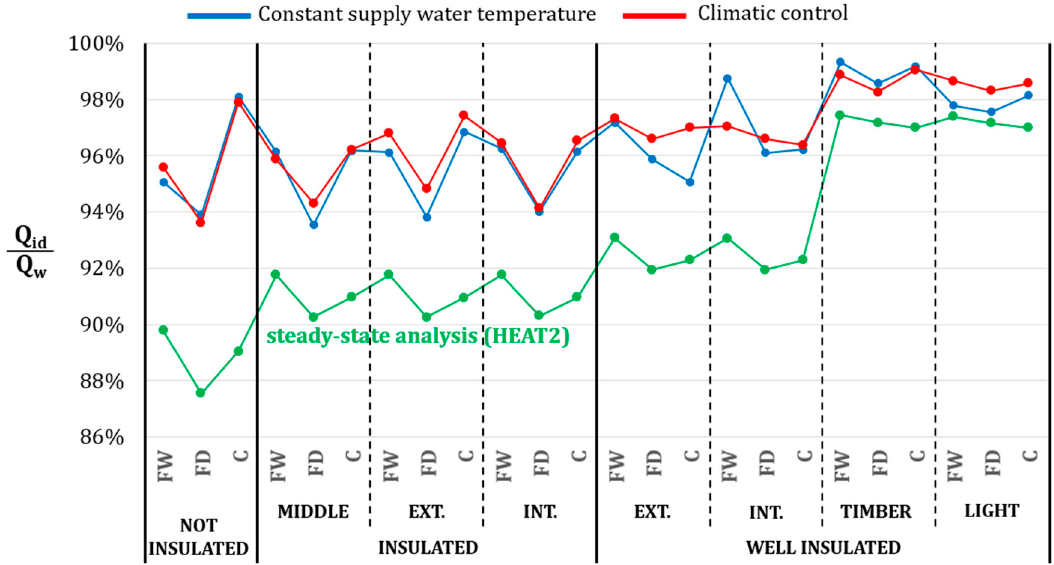
Figure 7. Efficiency of the radiant systems over the whole heating season and (in green) efficiency in steady-state conditions.